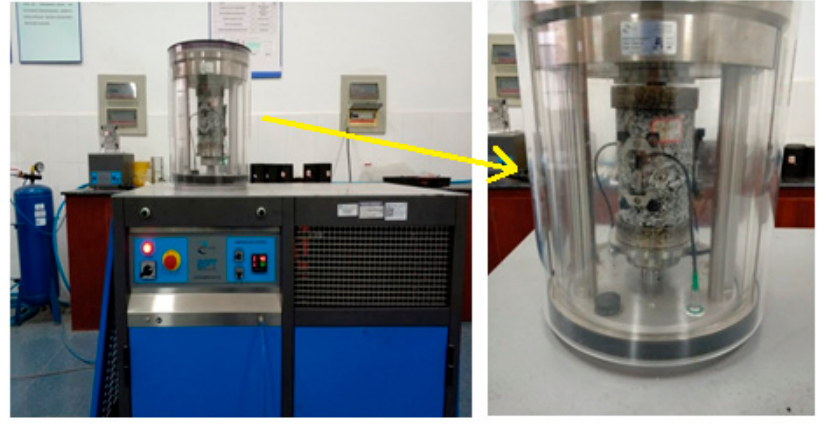
Figure 4. Simple Performance Tester.